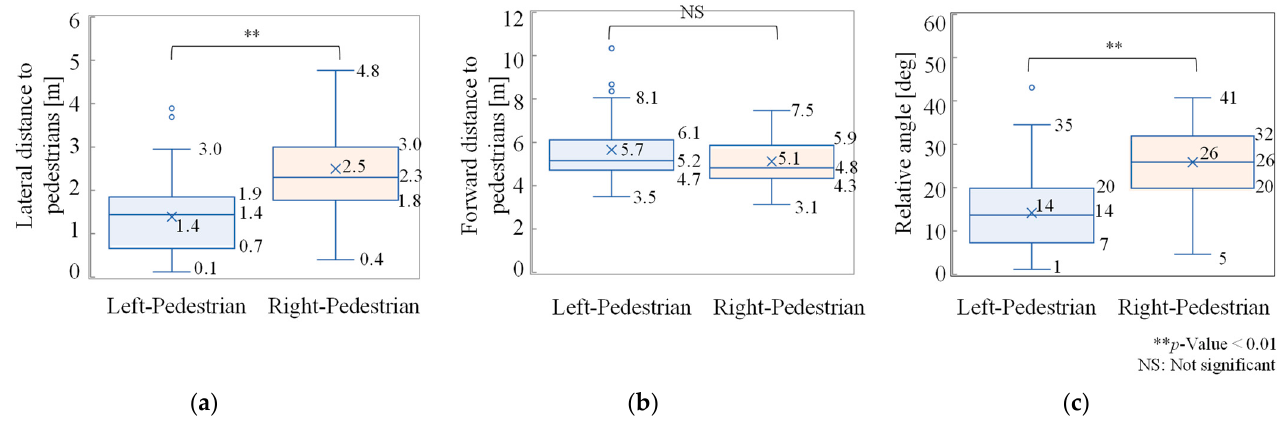
Figure 9. Lateral distances, forward distances, and relative angles between ego vehicles and pedestrians when the drivers applied the brakes: ( a ) lateral distances; ( b ) forward distances; ( c ) relative angles.